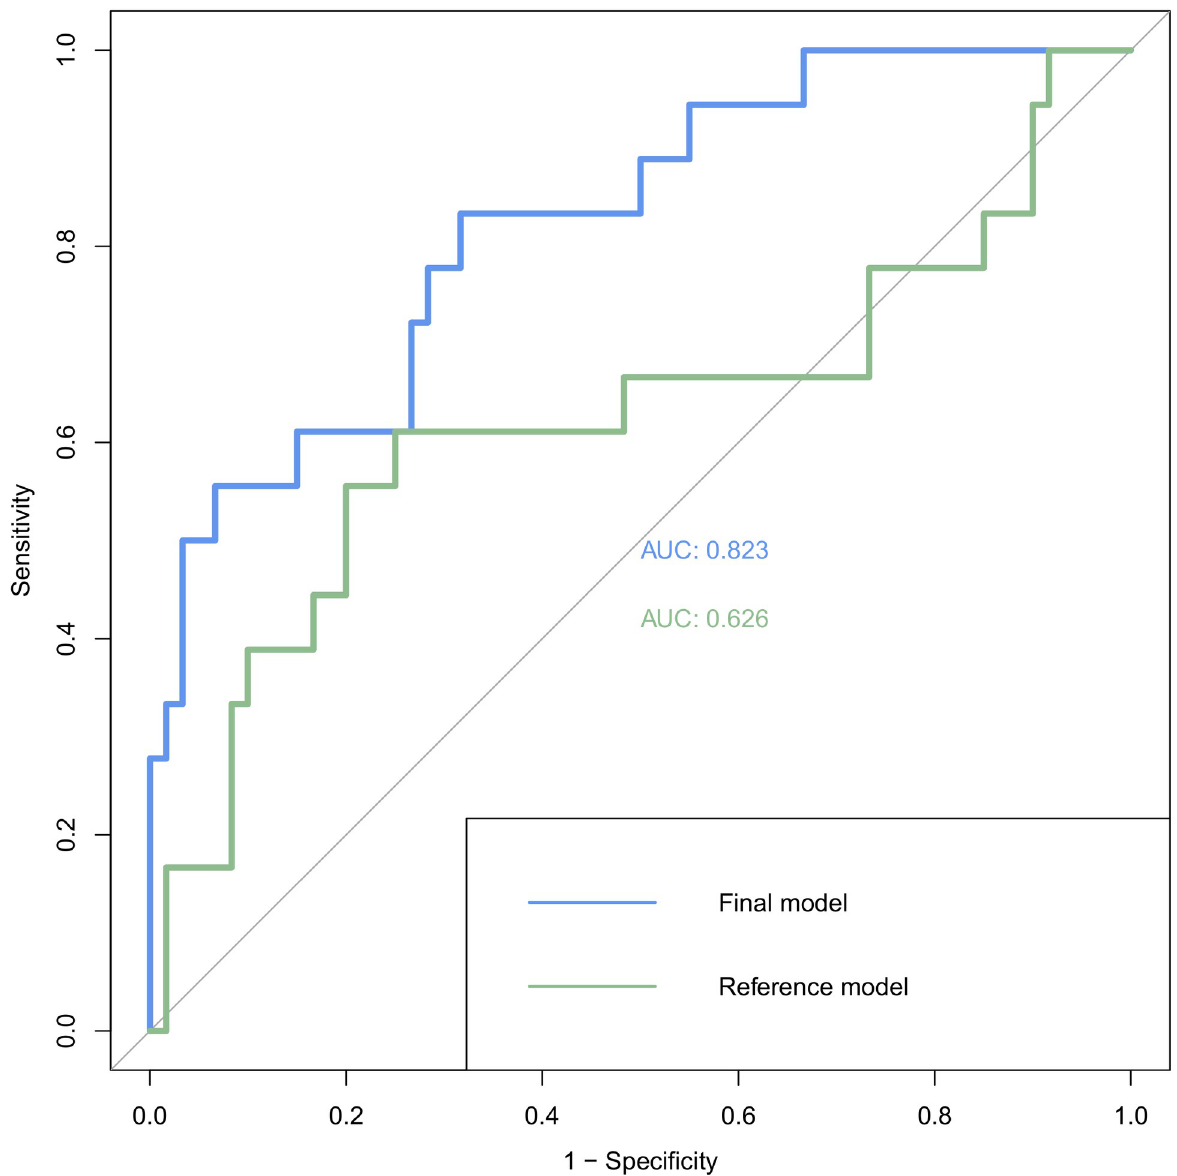
Fig 2. Receiver operating characteristic (ROC) curve analysis of the multivariate logistic model to detect preclinical AD using microbiome. The blue line represents the model with the presence or absence of nine genera revealed from the GLM analysis and covariates (i.e., age, sex, APOE4 positivity and BMI), while a green line represents the reference model including only the covariates. Abbreviation. AD: Alzheimer’s disease; APOE4: apolipoprotein E ε 4; BMI: body mass